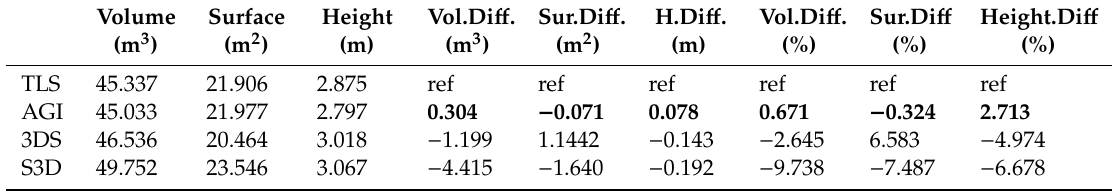
Table 3. Boulder No. 1: volume, surface area and height and particular model differences.